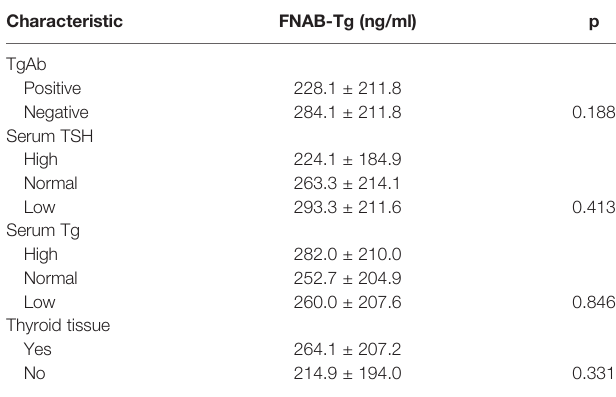
TABLE 5 | Distribution of FNAB-Tg in positive lymph nodes with different